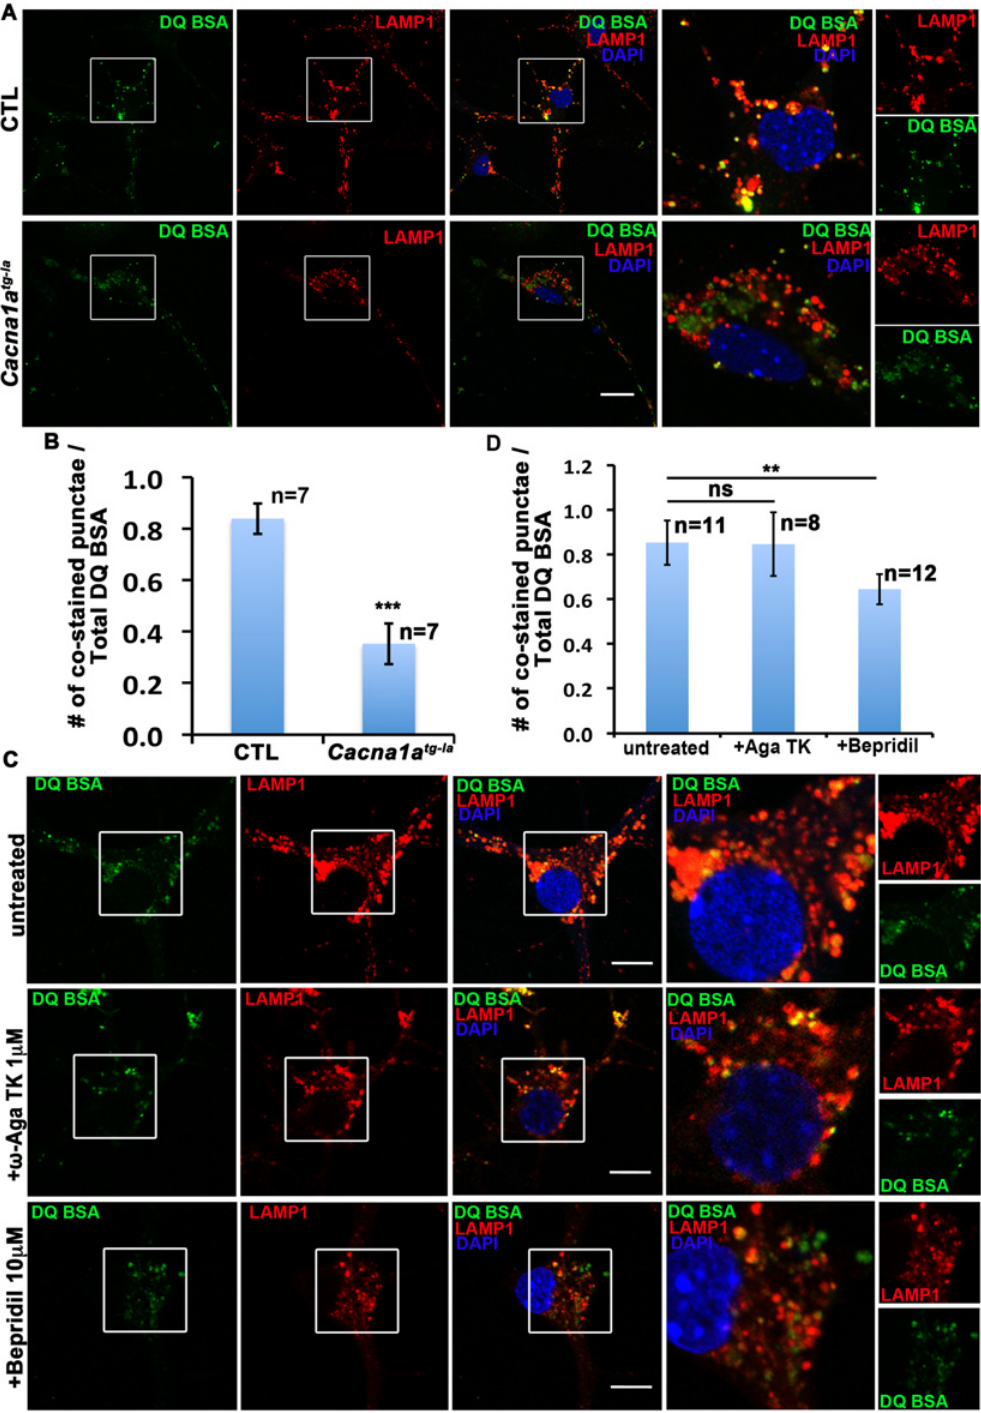
Fig 7. The calcium channel activity of CACNA1A on the lysosome, not the plasma-membrane is required for lysosomal fusion. A. DQ-BSA labeled late endosomes fuse with LAMP1 labeled lysosomes in CTL but not the mutant cells. Scale bar, 20 μ m. B. Quantification of DQ-BSA and LAMP1 co- localization in CTL and Cacna1a tg-la cells. Data are presented as means ± SD. (ns: not significant; *** : p < 0.001) C. Bepridil but not ω -agatoxin TK ( ω -Aga TK) treatment reduces lysosomal fusion in cultured cerebellar cells. DQ-BSA (Green) labeled late endosomes co-localize with LAMP1 (Red) labeled lysosomes with/without ω -Aga TK (1 µ M) or Bepridil (10 µ M) treatment. Scale bar, 20 μ m. D. Quantification of DQ-BSA and LAMP1 co-localization with ω -Aga TK or Bepridil treatment. Data are presented as means ± SD. (ns: not significant; ** : p < 0.001).